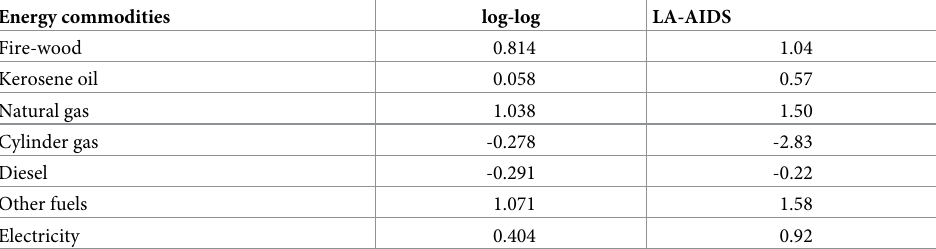
Table 9. The income elasticities from different